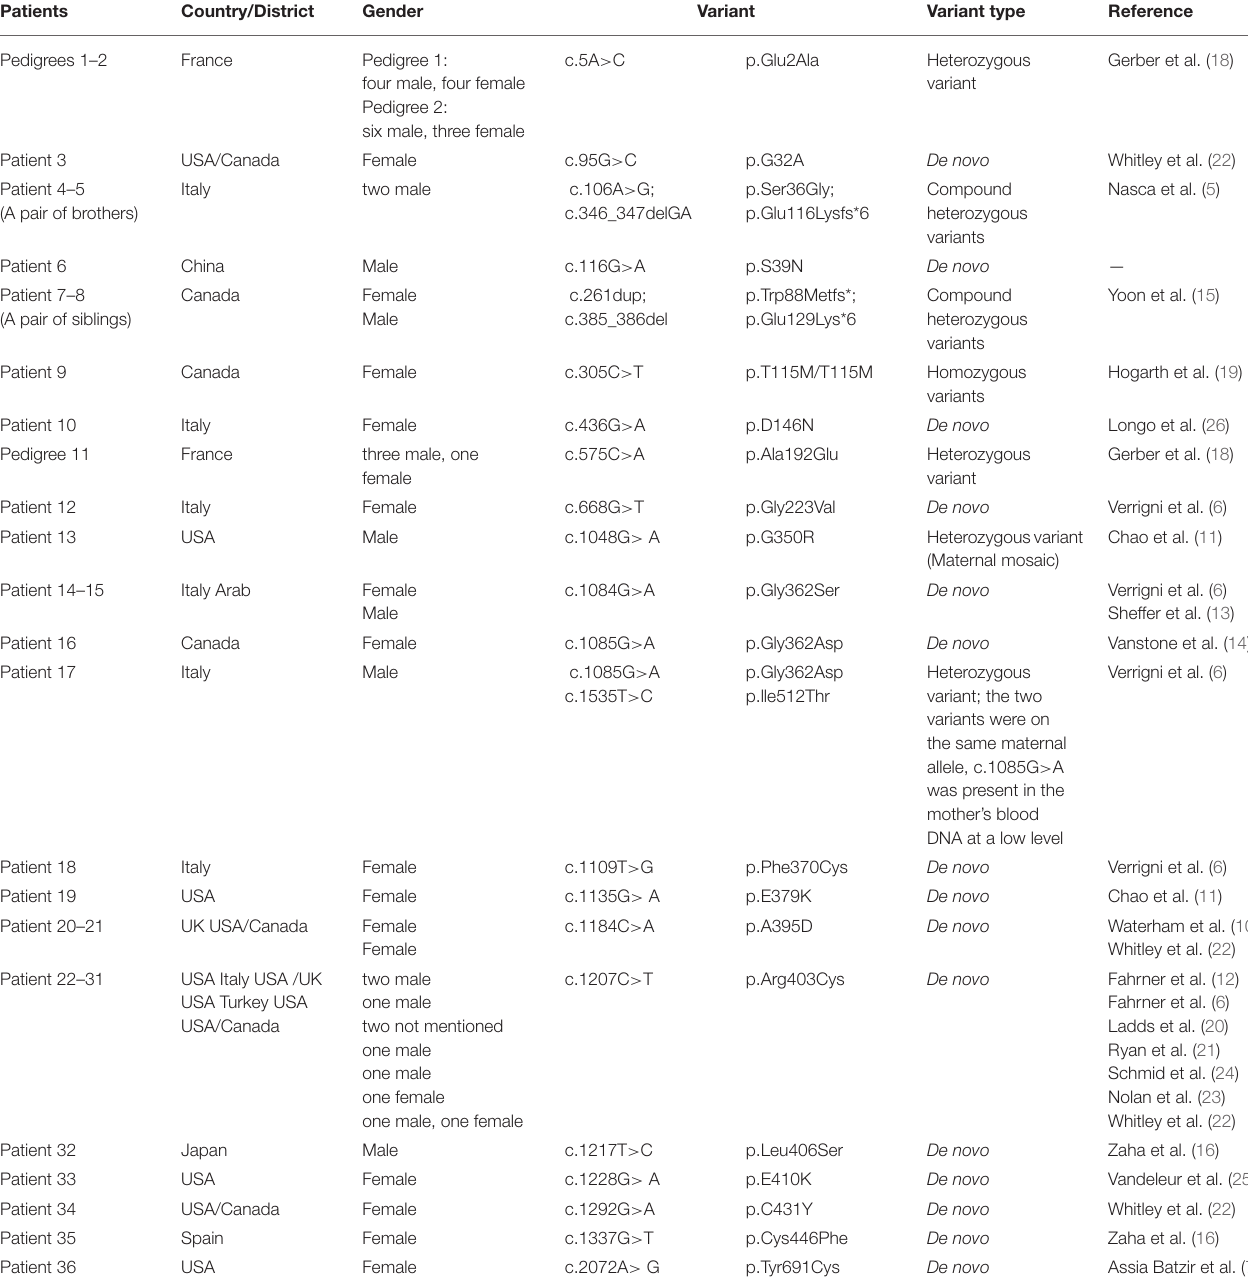
TABLE 2 | Related patient’s information and variants in DNM1L . Patients Country/District Gender Variant Variant type